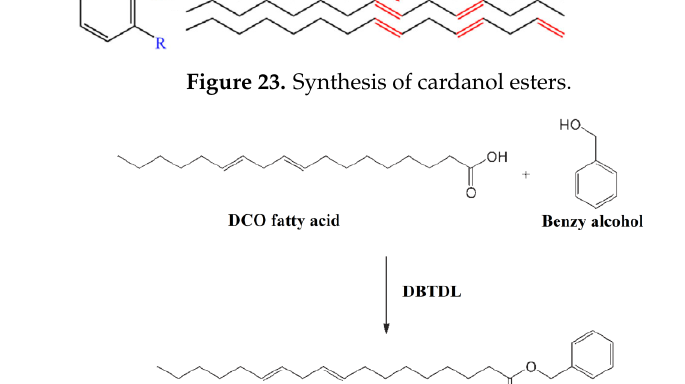
Figure 23. Synthesis of cardanol esters.